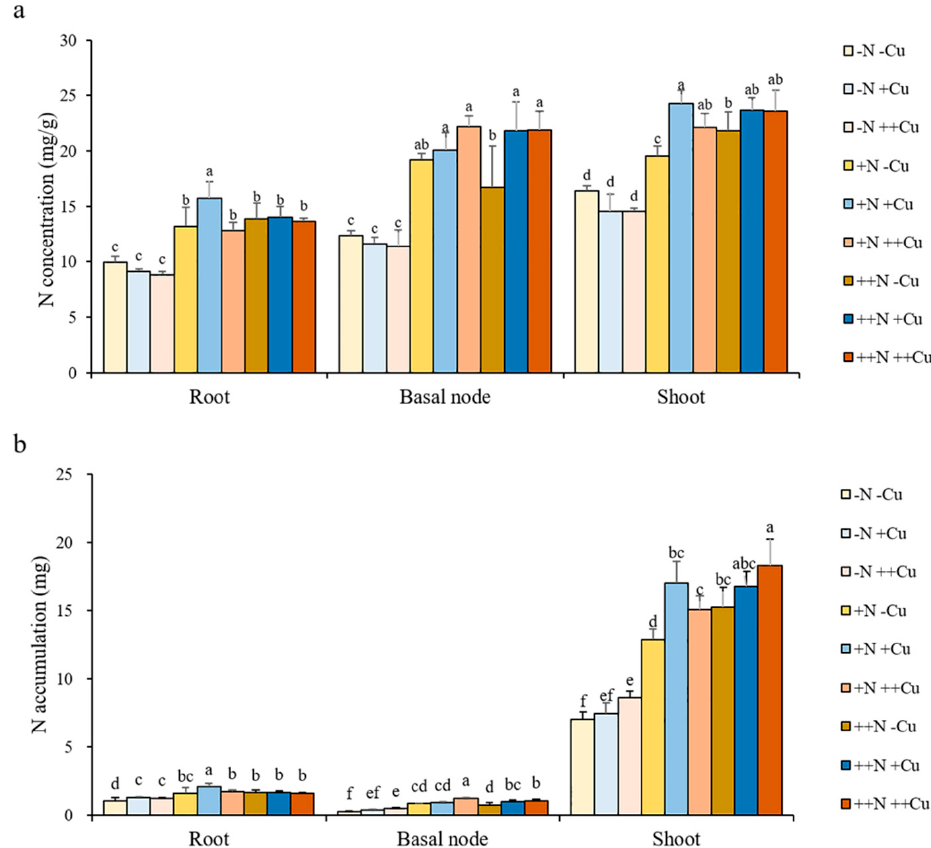
Figure 2. N concentration ( a ) and accumulation ( b ) in the root, basal node, and shoot of rice plant grown in solutions with different combinations of Cu (-Cu, 0 µ M; +Cu, 0.15 µ M; ++Cu, 1.5 µ M) and N (-N, 0.288 mM; +N, 2.88 mM; ++N, 14.4 mM) supply for three weeks. The N accumulation was calculated as N concentration × dry weight. Data are means ± SD of three biological replicates. Different letters indicate significant difference at p < 0.05 by Tukey’s